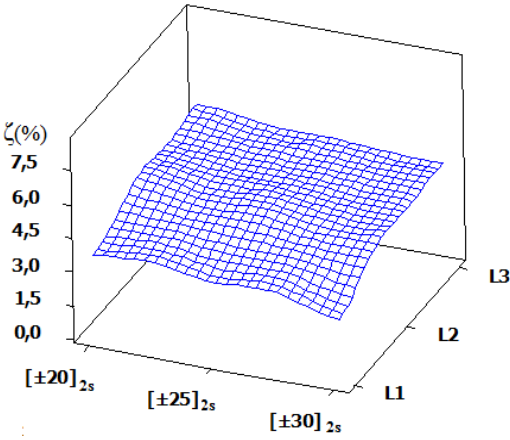
Figure 8. Effect of staking sequences and attached mass locations on damping ratio